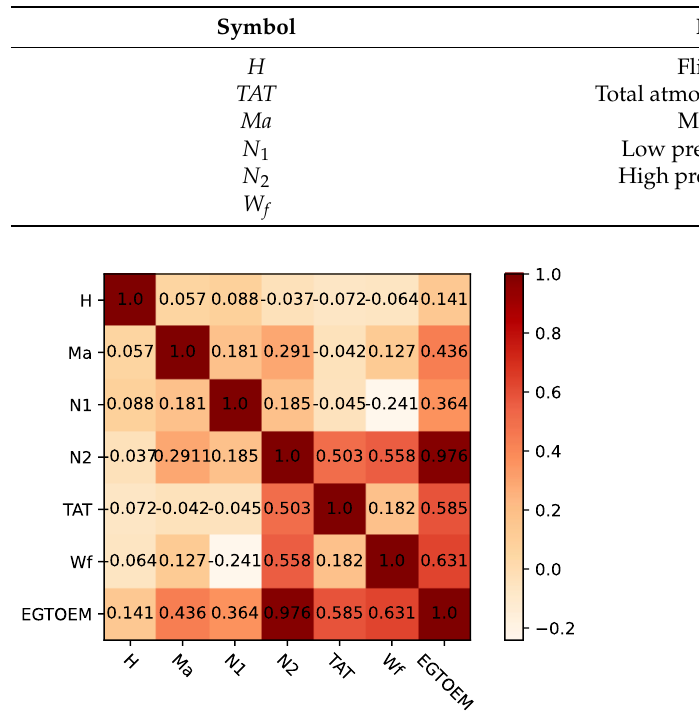
Table 1. Model input parameters.